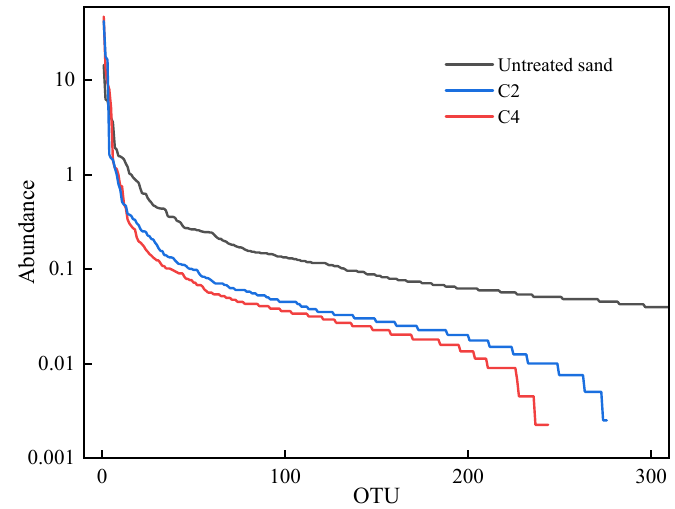
Figure 15. Rank abundance curves for different samples.